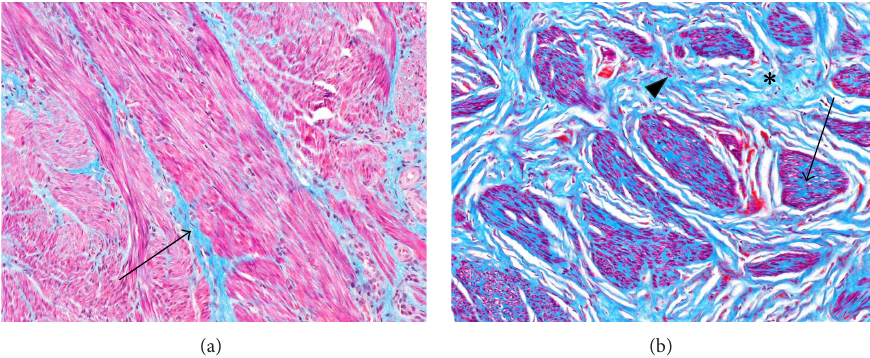
Figure 1: Intrafascicular and interfascicular fibrosis. (a) Masson’s trichrome stain of normal myometrium for comparison with (b) Phase 3 fibroid, also stained with Masson’s trichrome, which stains muscle red and collagen blue. Note that in the myometrium (a) most of the blue staining collagen is between the fascicles (interfascicular) (arrow), whereas blue collagenous stroma in the fibroid is also noted between the individual myocytes of the muscle fascicles (intrafascicular fibrosis) (arrow), without the interposition of fibroblasts, indicating that the collagenous stroma is being produced by the myocytes themselves. In addition, the interfascicular blue collagenous stroma (asterisk) is more abundant in the fibroid (b) than in the myometrium (a). Red staining cells within the interfascicular stroma of the fibroid (arrowhead) probably represent transformed myocytes, or fibroblasts. Original objective magnification of (a) and (b): 10x.